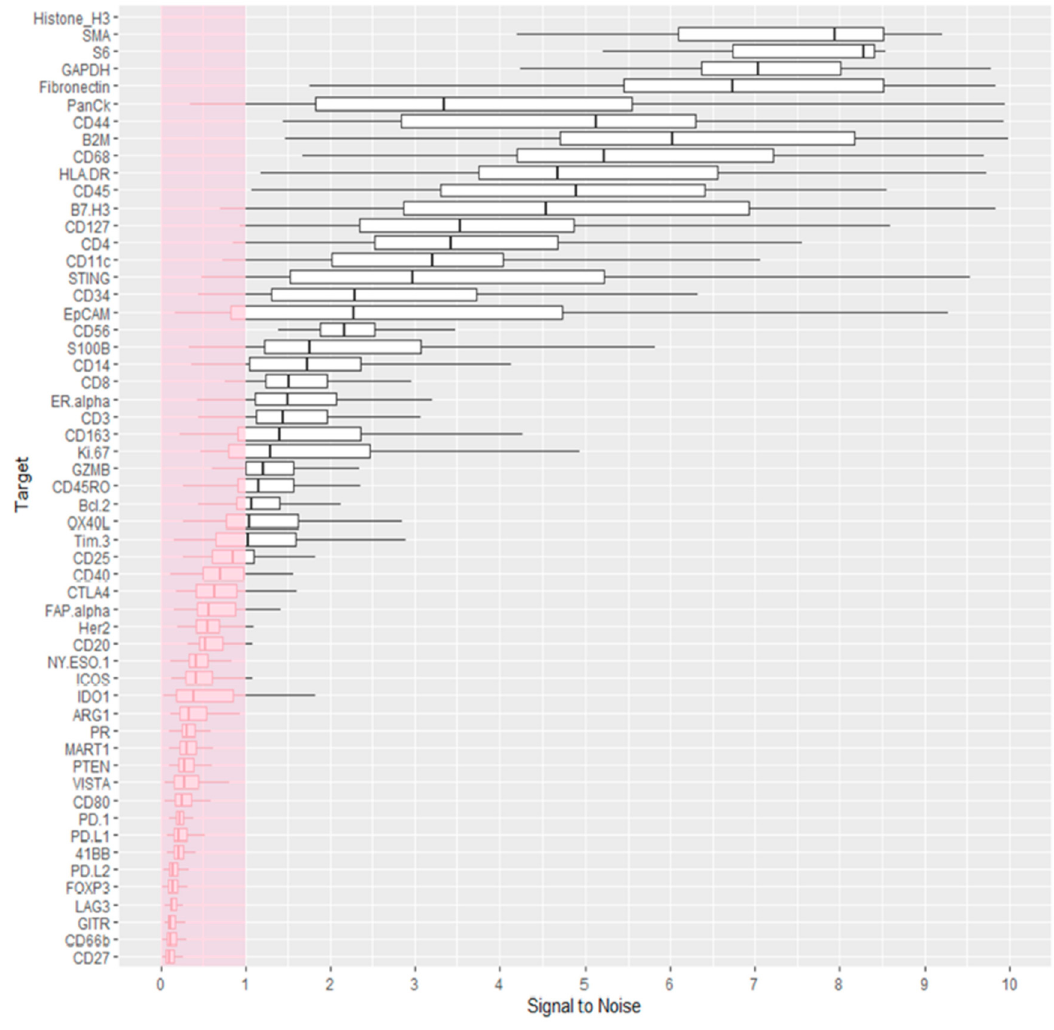
Figure 3. Probe counts relative to rabbit (Rb) and mouse (Ms) IgG controls. Counts of each probe were normalised to mean counts of Rb and Ms IgG within each ROI. The mean of these normalised values per probe was plotted to evaluate the robustness of the target protein signal to isotype background controls.